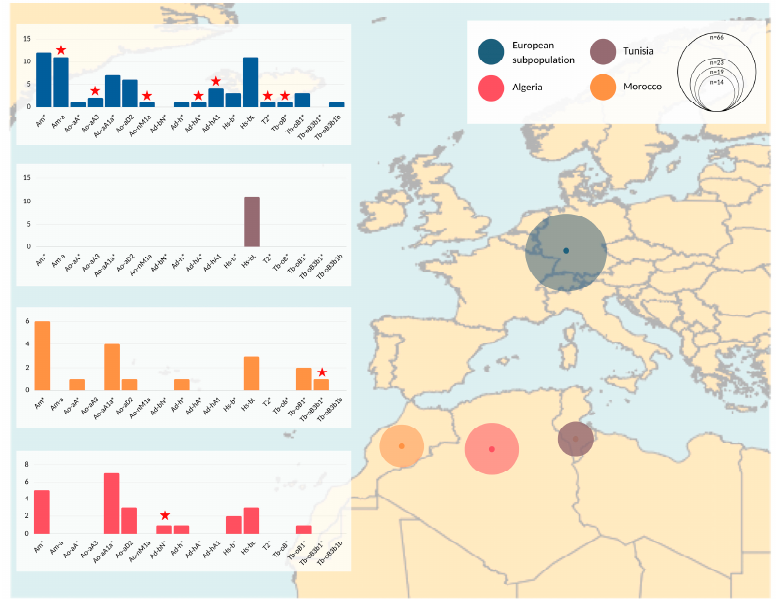
Figure 2. Geographical representation of MSY haplotypes. Populations analyzed are denoted with different colors and circles on the map correspond to the sample size. Details are given in Supple- ment, Table S1. Summary information of genotyping results and regional differences are visualized